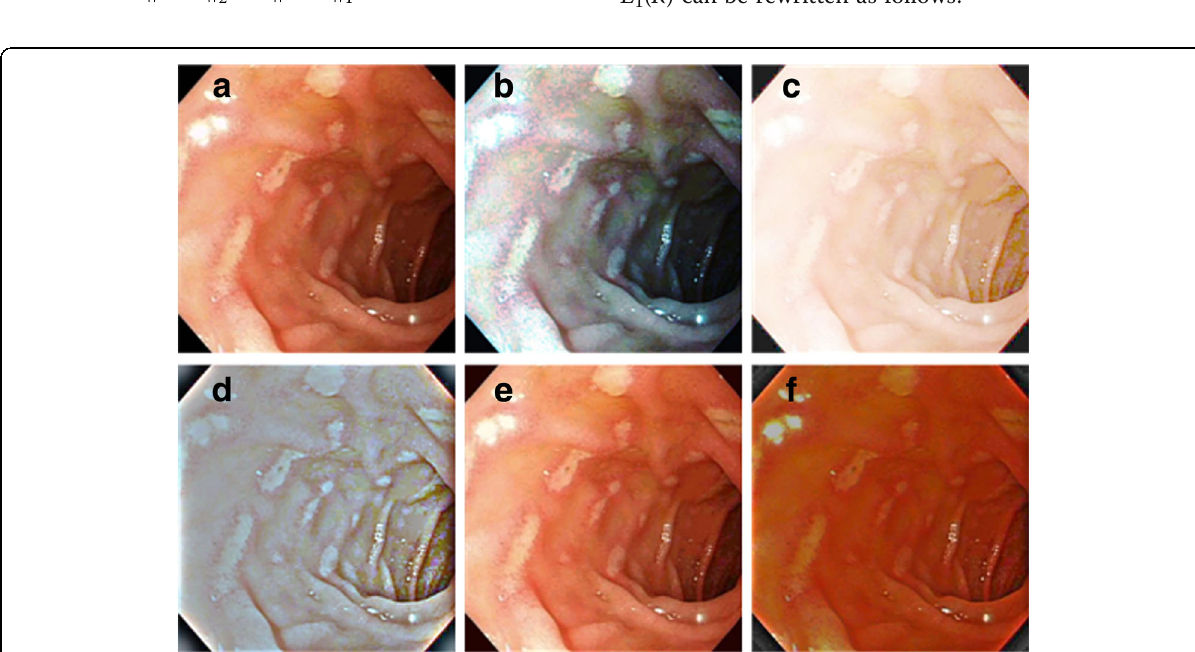
Fig. 10 Enhanced results using different methods. a Original image. b LHE. c MSR. d SARV. e NPEA. f AD- L 1 L 2 VR